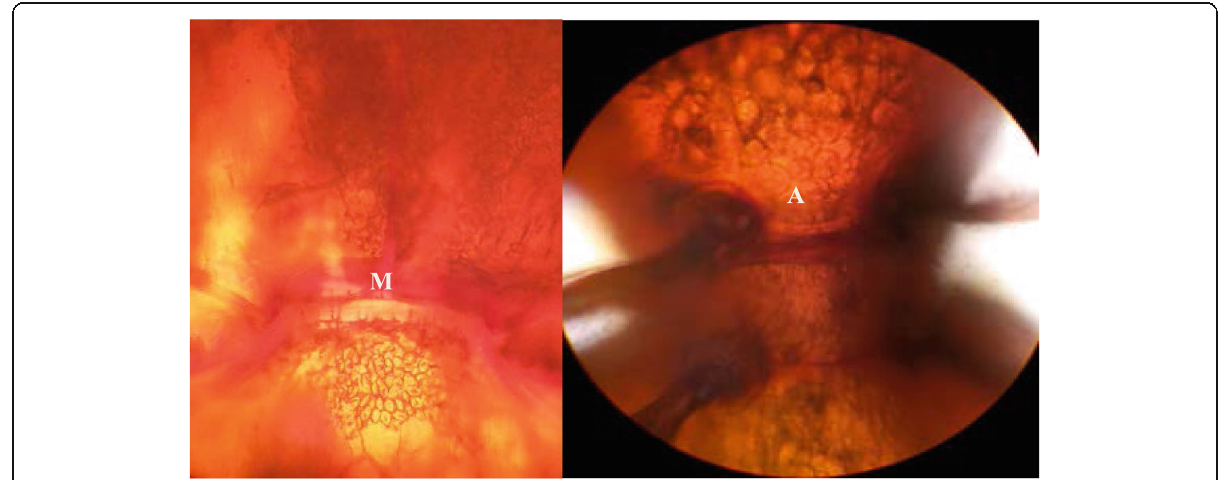
Fig. 6 Light microscope views of Mattesia spores (M) and Adelina oocysts (A) distinctly seen through the sternites of Laemophloeus turcicus beetle (×100 to ×400